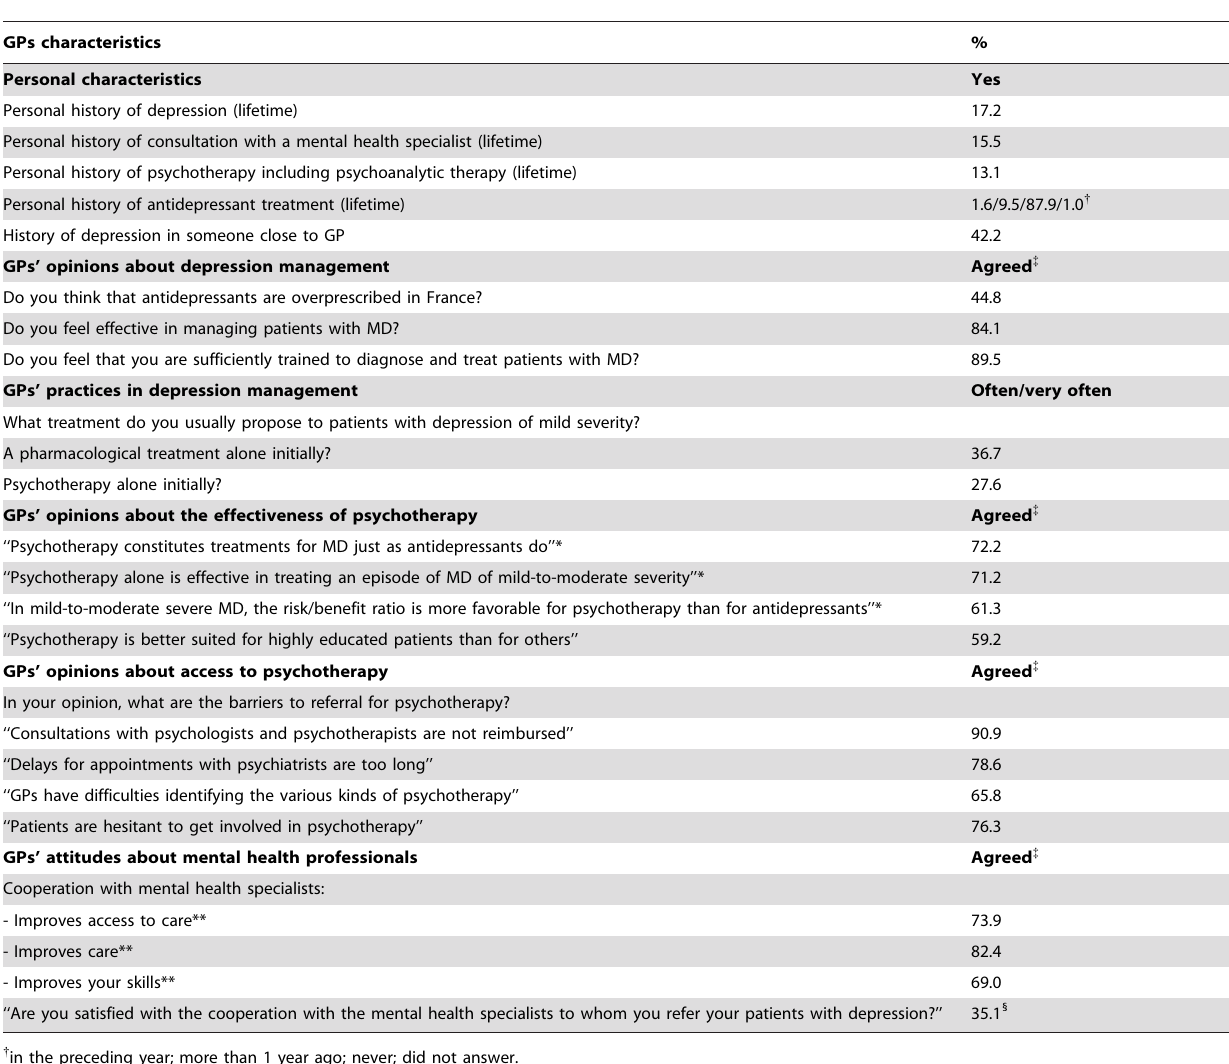
Table 2. GPs’ personal characteristics and attitudes about the management of depression (French nationwide panel of general practitioners, weighted data,